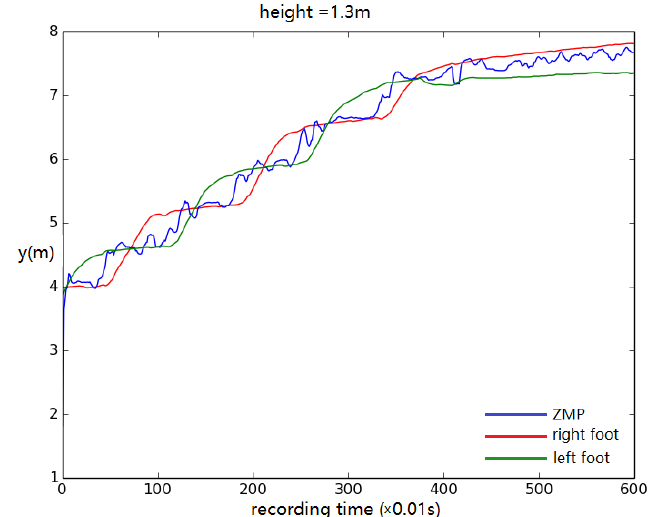
Figure 13. Foot and ZMP displacement when the body height is set to 1.3 m. Displacement of torso center of mass vs.